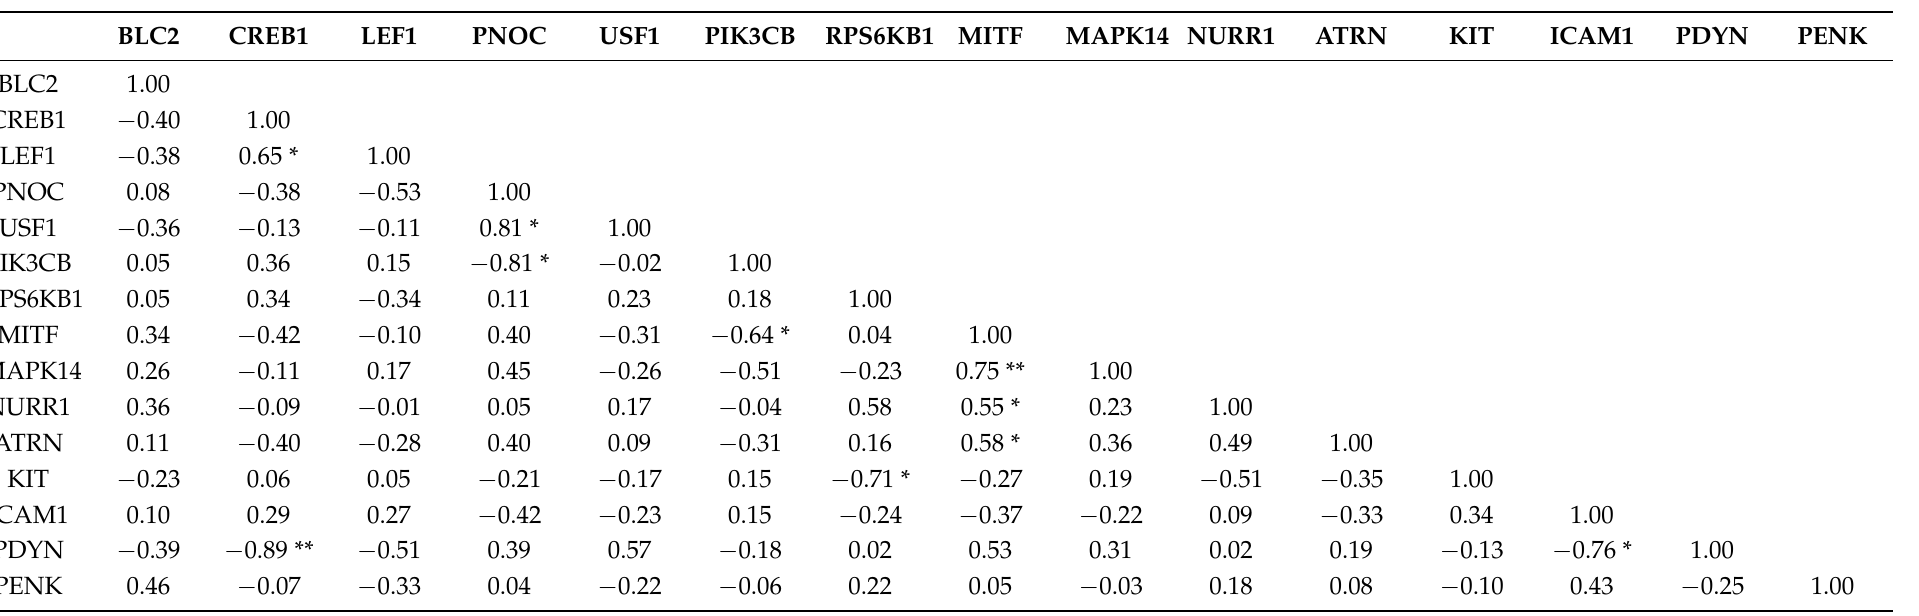
Table 2. Results of correlation analysis of gene expression in non-lesional skin biopsies of psoriasis patients. Spearman rank correlation coefficient (Spearman r) was used; * p < 0.05; ** p <